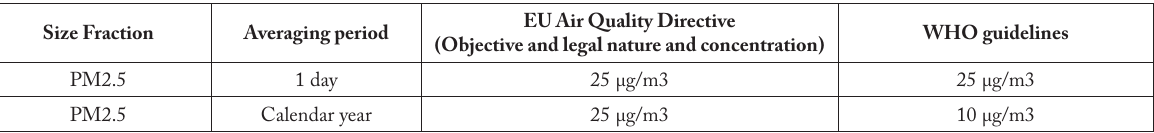
Table 4. Air Quality Limit and Target Values, for PM10 and PM2.5 as given in the EU Ambient Air Quality Directi-